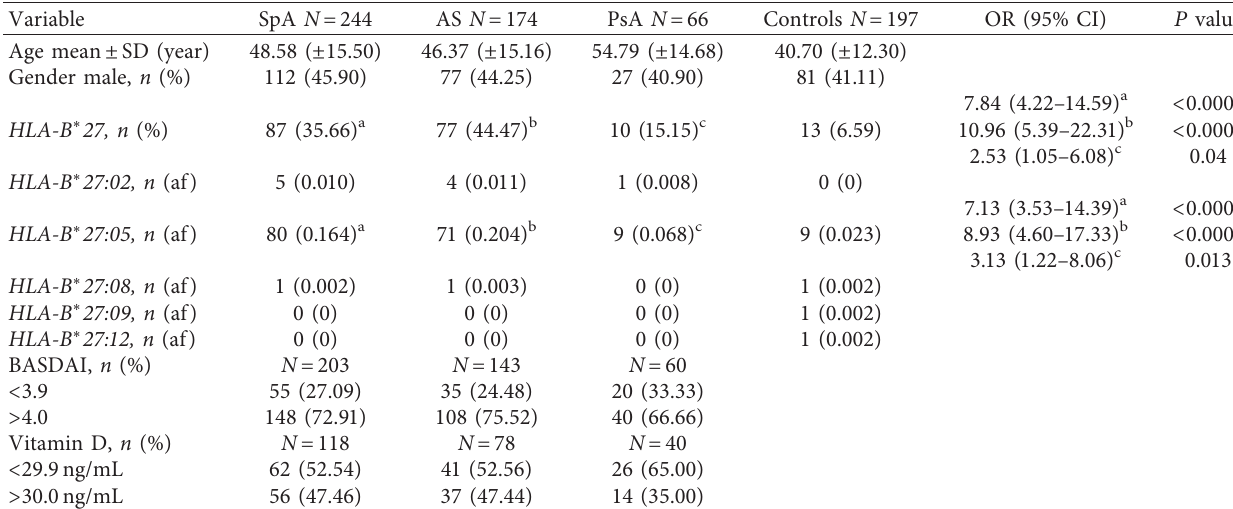
Table 1: Characteristics of patients with spondyloarthritis (SpA), ankylosing spondylitis (AS), and psoriatic arthritis (PsA) and controls. Variable